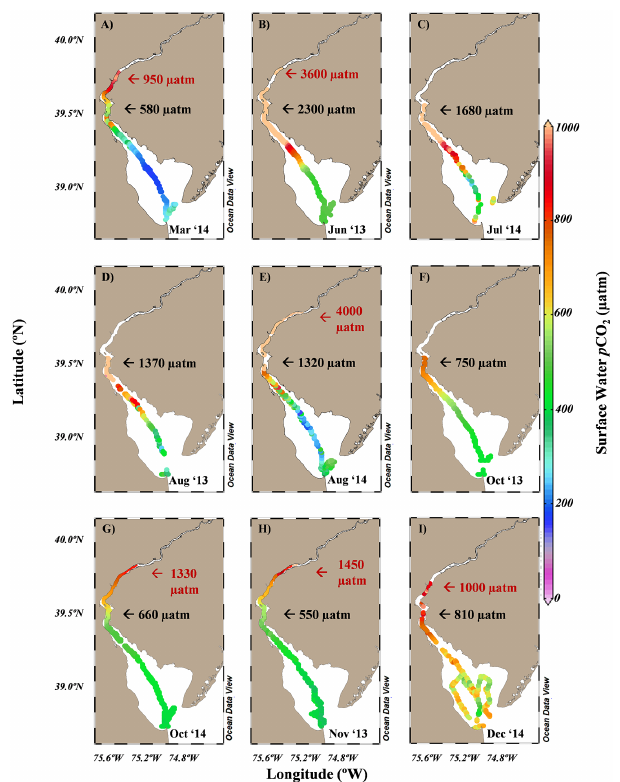
Figure 6. Spatial distributions of surface water p CO 2 in the Delaware Estuary measured during each sampling month. Black and red arrows show surface water p CO 2 values at the Chesapeake and Delaware Canal and the northern end-member of each survey, respectively. The map was designed with the ODV software by R.